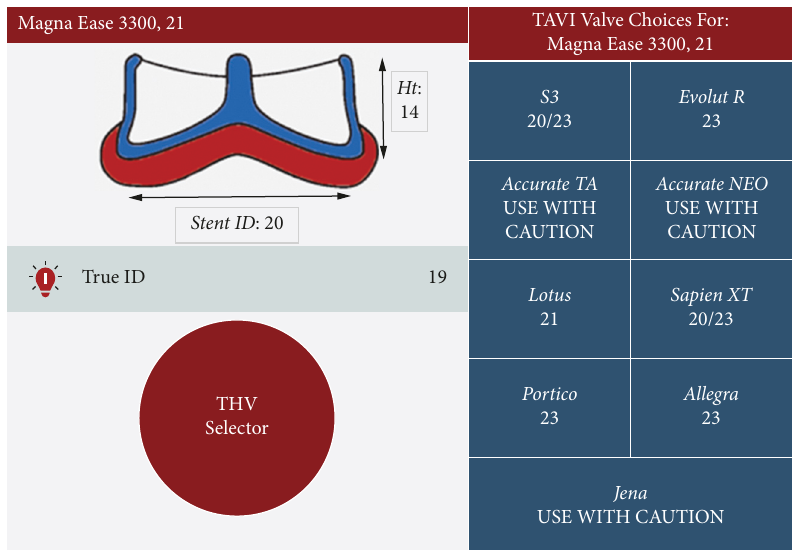
Figure 1: Example of some information obtained in the ViV Aortic App. In this simulation, the true ID for a Magna Ease 21mm bioprosthesis is 19mm, and a TAVR using an Evolut R 23mm self-expanding or a Sapien 3 20/23mm balloon-expandable would be